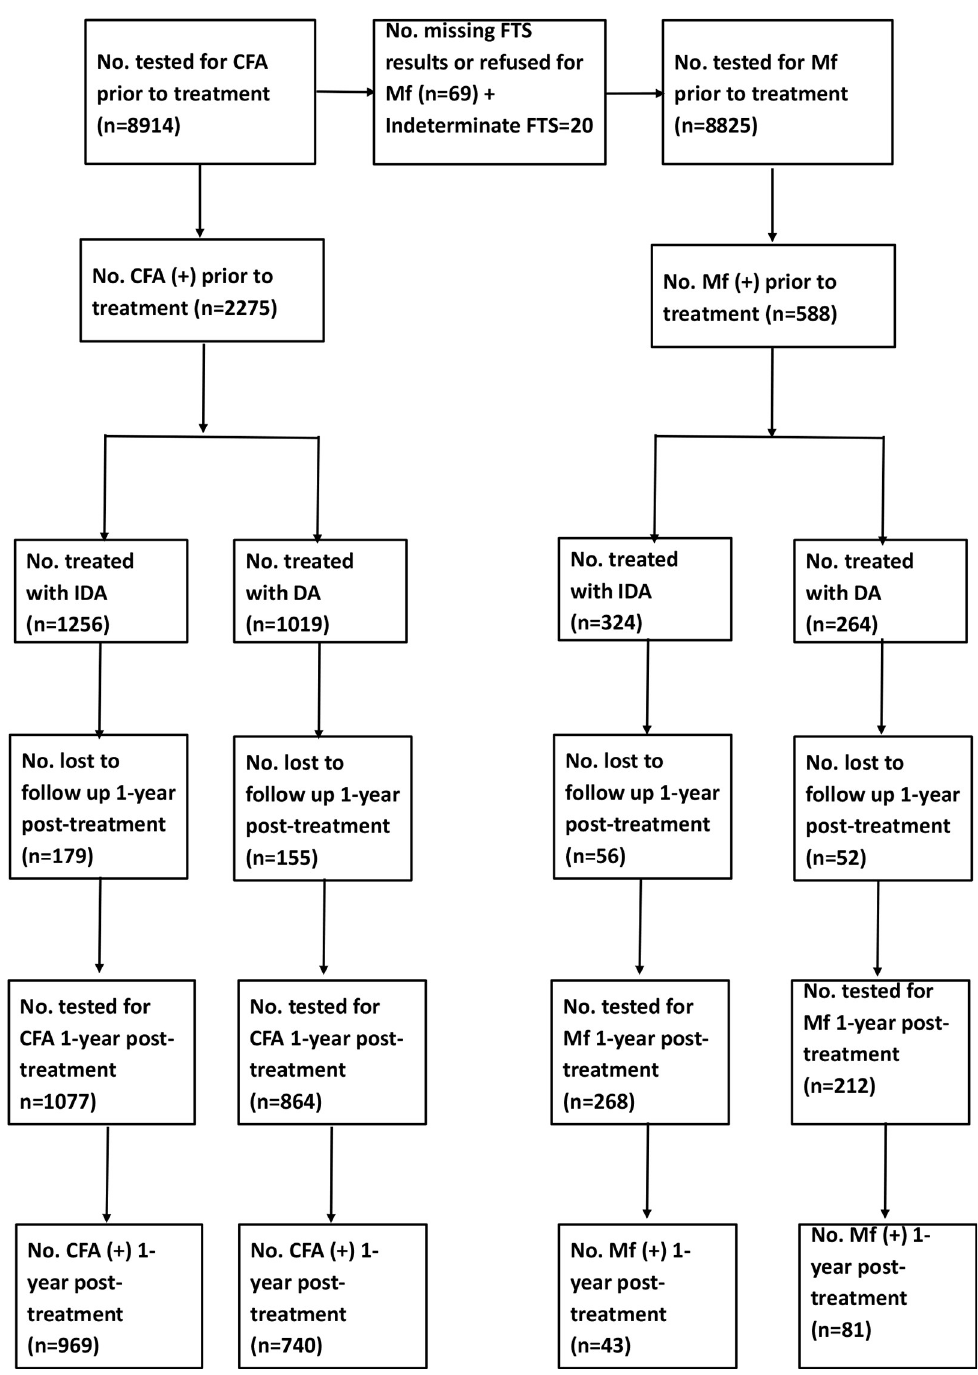
Fig 5. CONSORT diagram. Information on individuals with filarial infections at baseline and who were retested and retreated 1-year post-treatment. for reducing Mf counts than DA (90.0%). An analysis of covariance (ANCOVA) showed that the reduction in GMf density was significantly greater after IDA than after DA after adjusting for age, gender and baseline Mf count (P < 0.002).